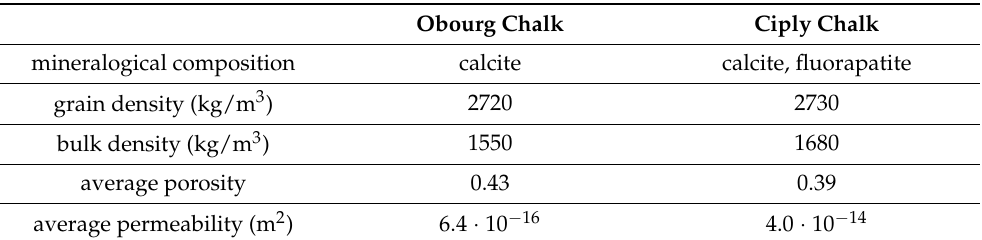
Table 1. Composition and petrophysical properties of the selected